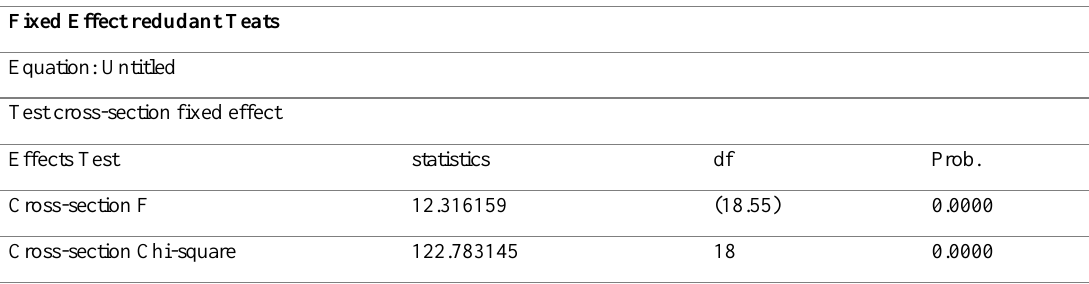
Table 6: Chow test output